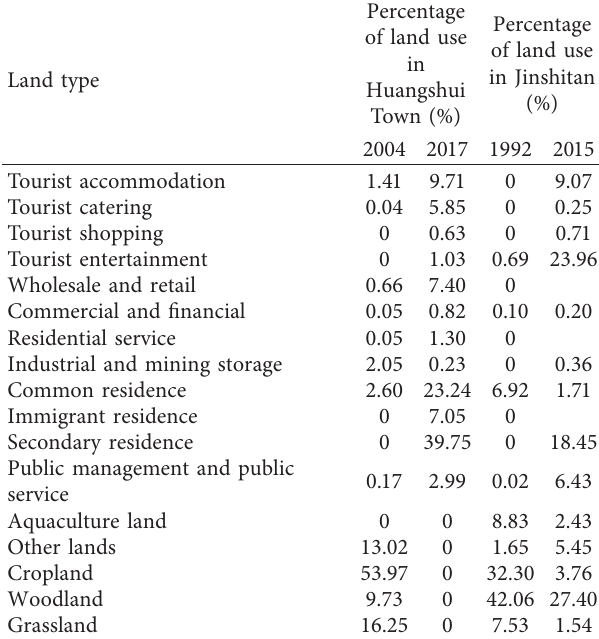
Table 3: Evolution of internal functions of tourist